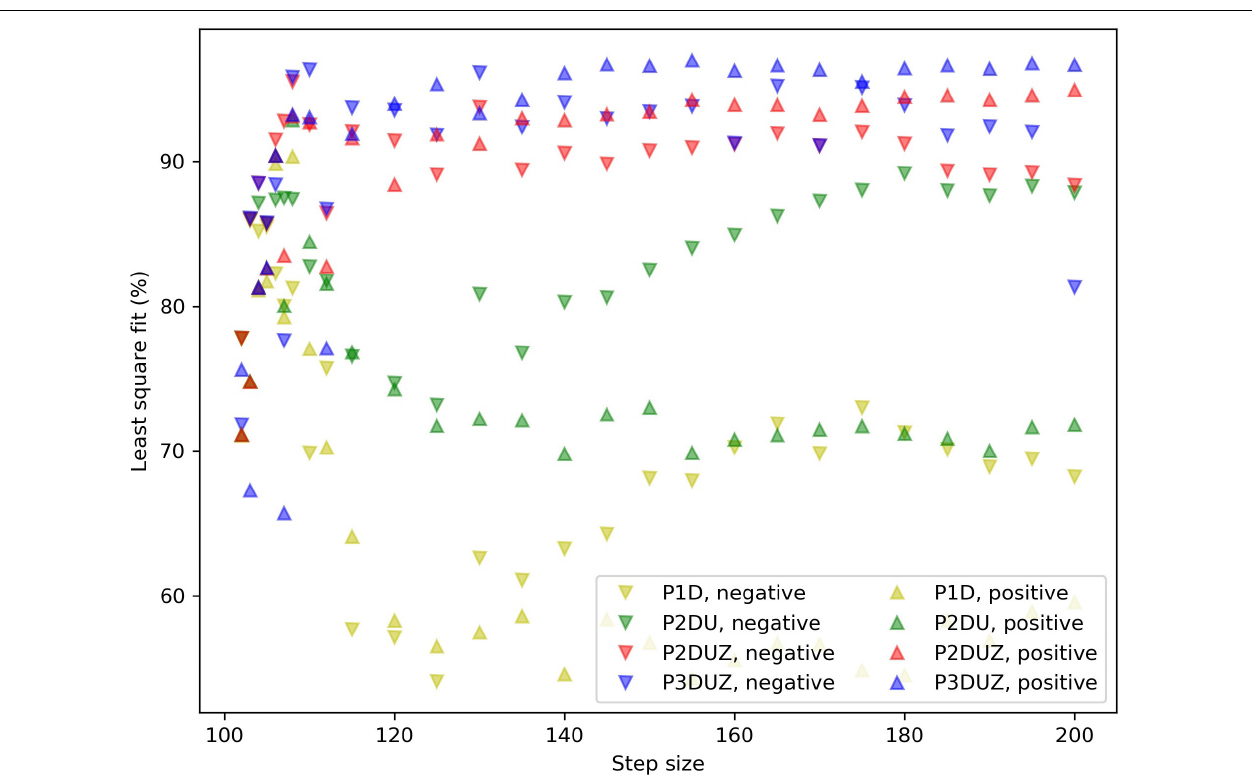
FIGURE 5 | Fit ratios for four models (P1D, P2DU, P2DUZ, and P3DUZ), on data aggregated over three participants. Negative steps are depicted with ( ∨ ) and positive ones with ( ∧ ).